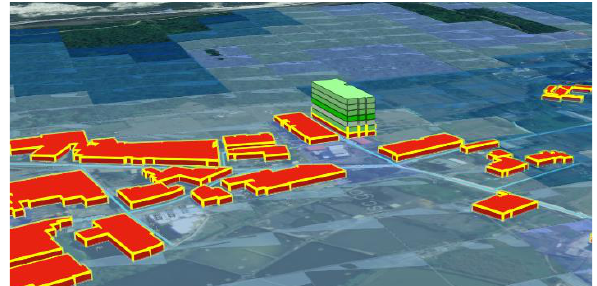
Figure 14. Visualization of high buildings for evacuation